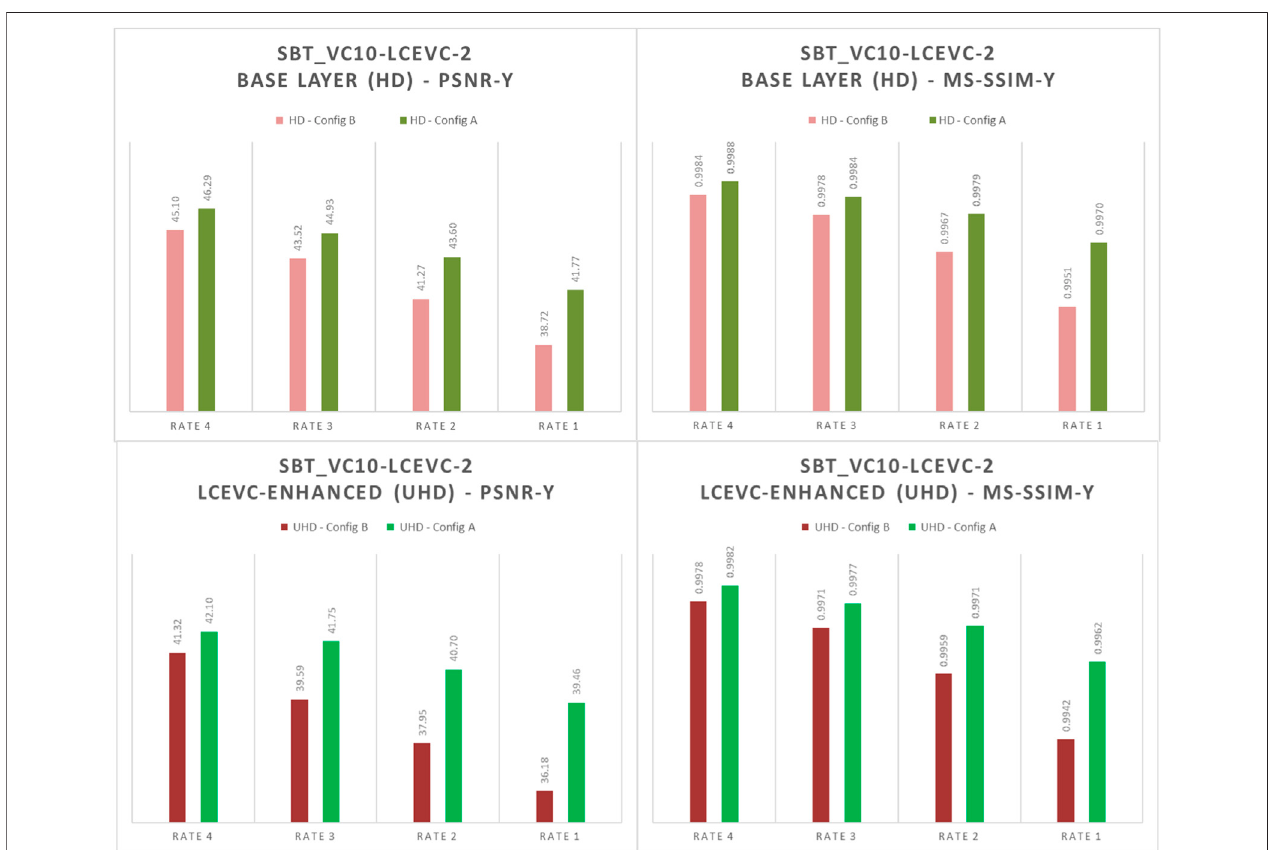
FIGURE 9 | Comparison of MS-SSIM-Y and PSNR-Y between the base layers (HD) under Con fi guration A (green) and Con fi guration B (red) – SBT_vc10-lcevc- 2 (PQ)